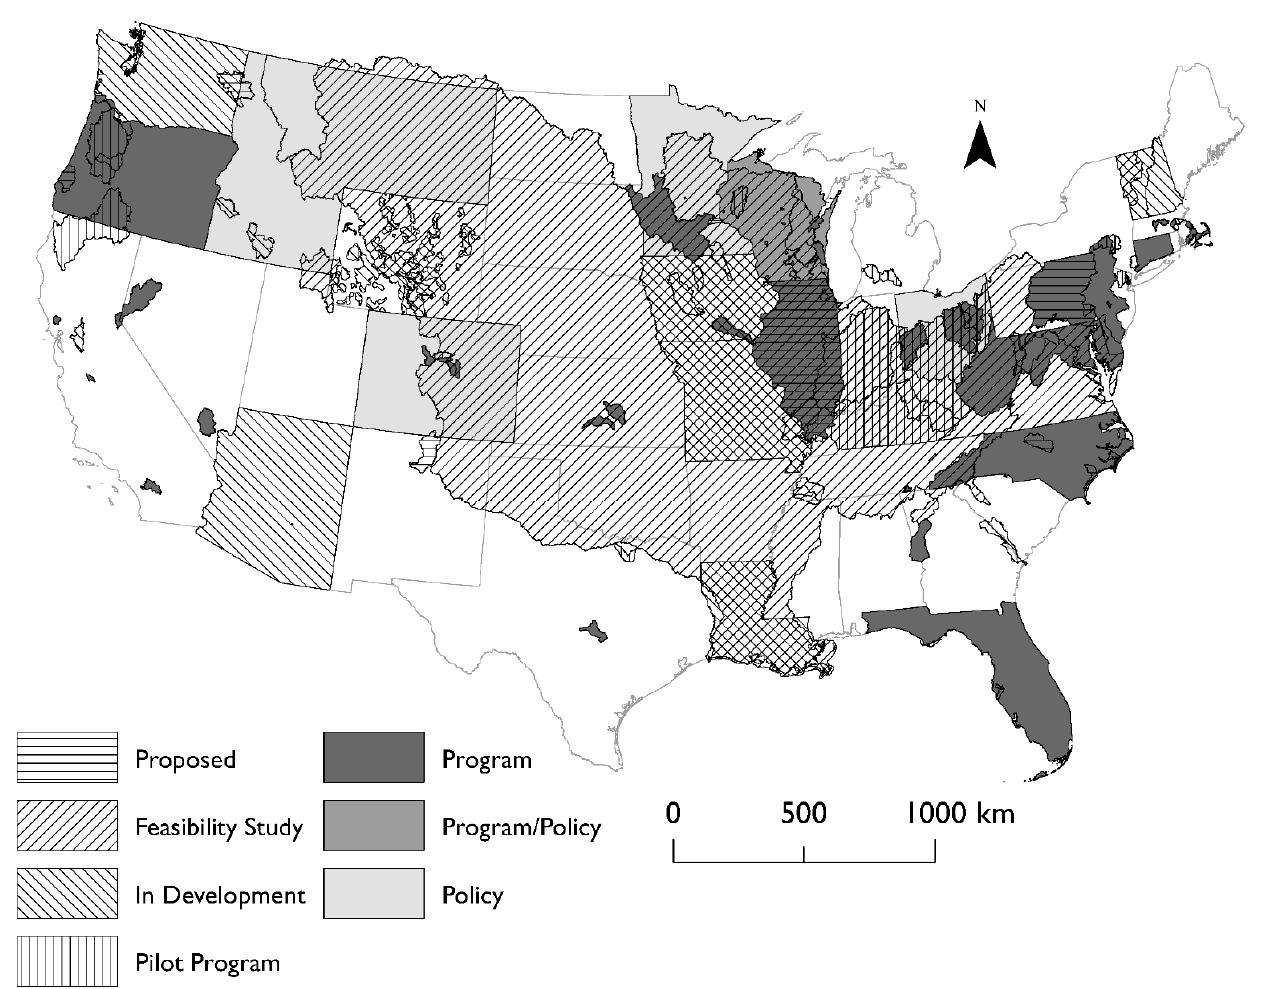
Figure 1. Map of the US water quality trading programs ( n = 141) and state-wide policies ( n = 6) by program stages.